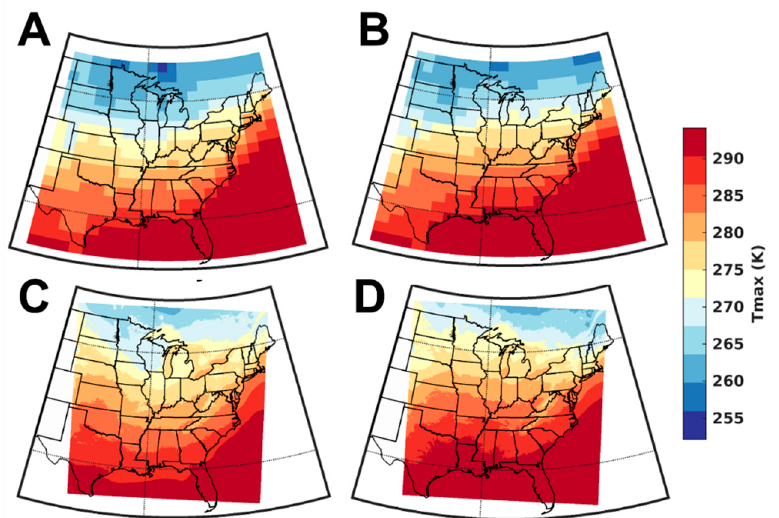
Figure 2. Monthly mean maximum 2-m temperature (Tmax) values for the two ENSO phases: ( A ) HadGEM2 output for January 1985 (El Niño); ( B ) HadGEM2 output for January 2000 (La Niña); ( C ) HadGEM2-WRF output for January 1985 (El Niño); ( D ) HadGEM2-WRF output for January 2000 (La Niña).